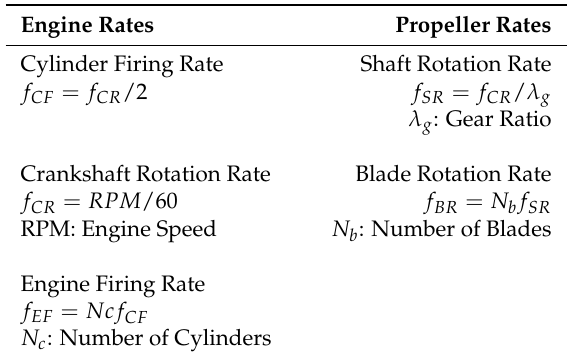
Table 1. Character frequencies of ship engine and